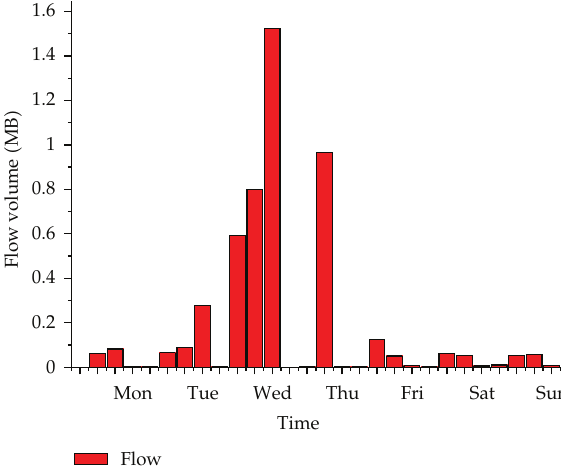
Figure 2: Tra ffi c volumes indexed by time intervals.